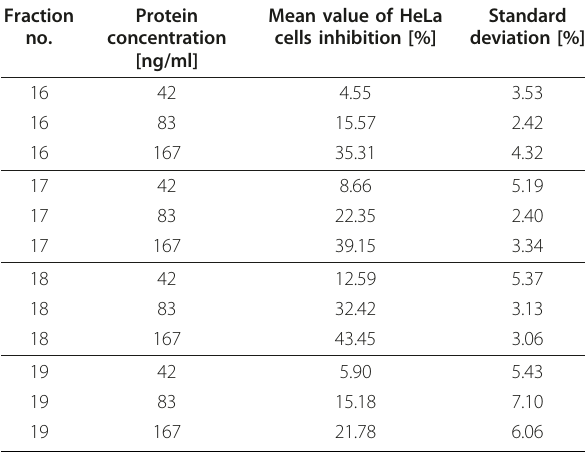
Proteins from three rounds of purification were administered at concentrations of 42; 83; and 167 ng/ml. The data was analyzed using